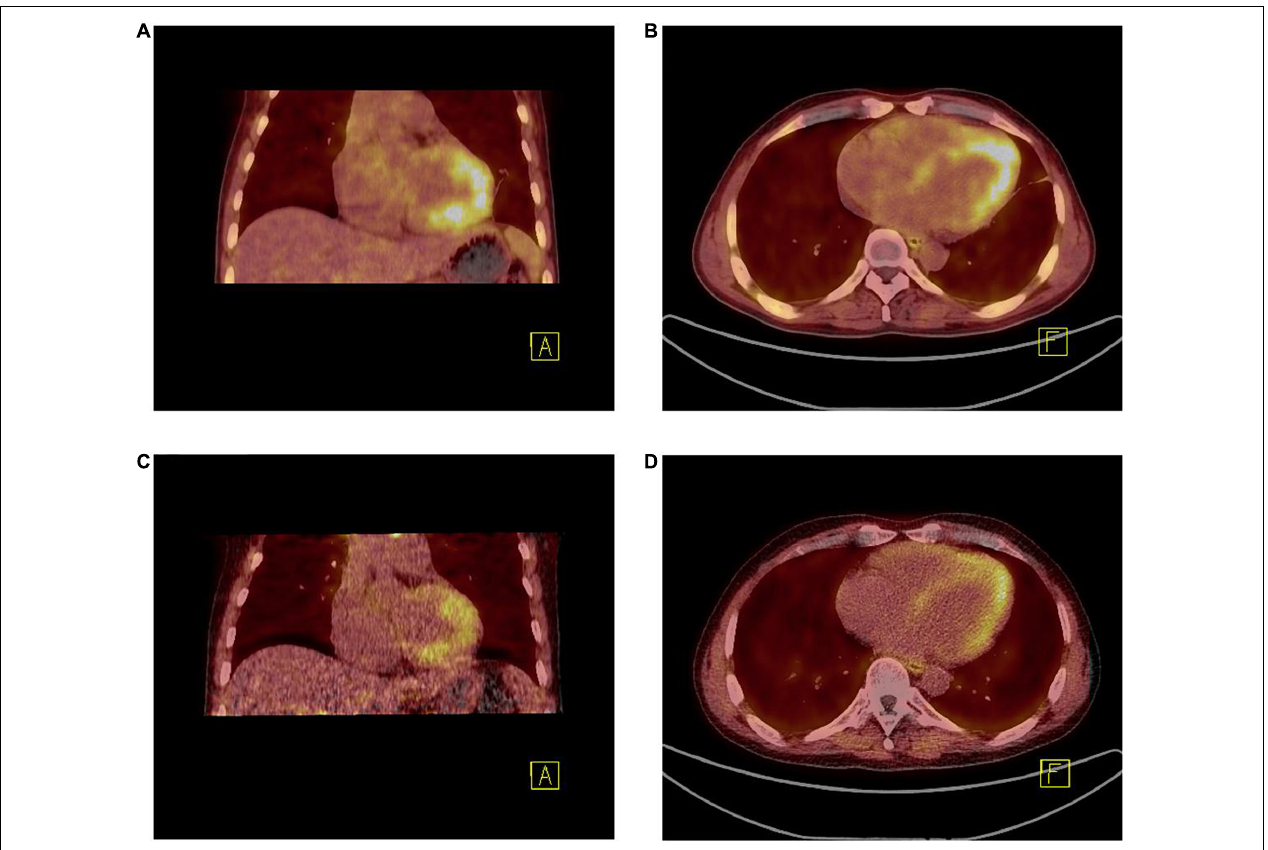
FIGURE 4 | (A,B) 18F-FAPI PET/CT fused image demonstrated the uptake [10.10 (SUVmax), 8.75 (SUVpeak), and 1.92 (SUVmean)] was much higher than that after 2 months of treatment (C,D) [8.40 (SUVmax), 6.91 (SUVpeak), and 1.32